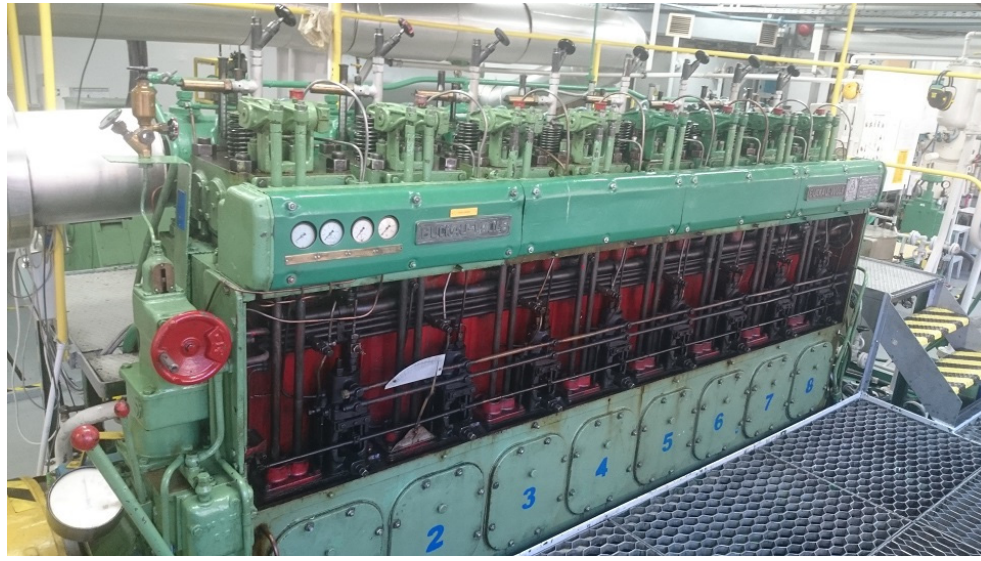
Figure 1. View of the analyzed Buckau-Wolf R8DV-136 engine.